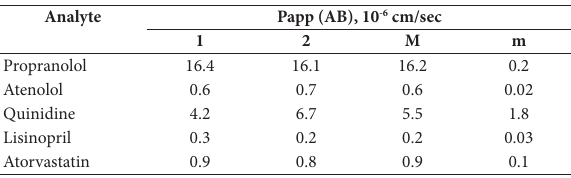
Table 9. Recovery data of transport of atorvastatin, lisinopril and the three reference compounds through a monolayer of cells of the